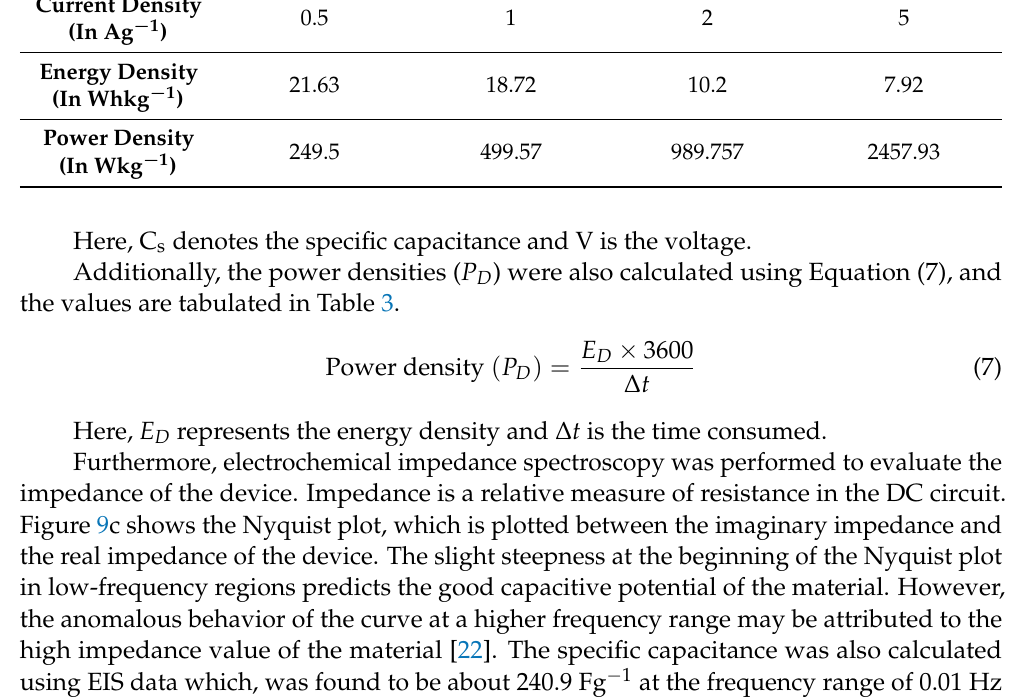
Table 3. The energy and power densities for different current densities. Current Density (In Ag − 1 ) Energy Density Power